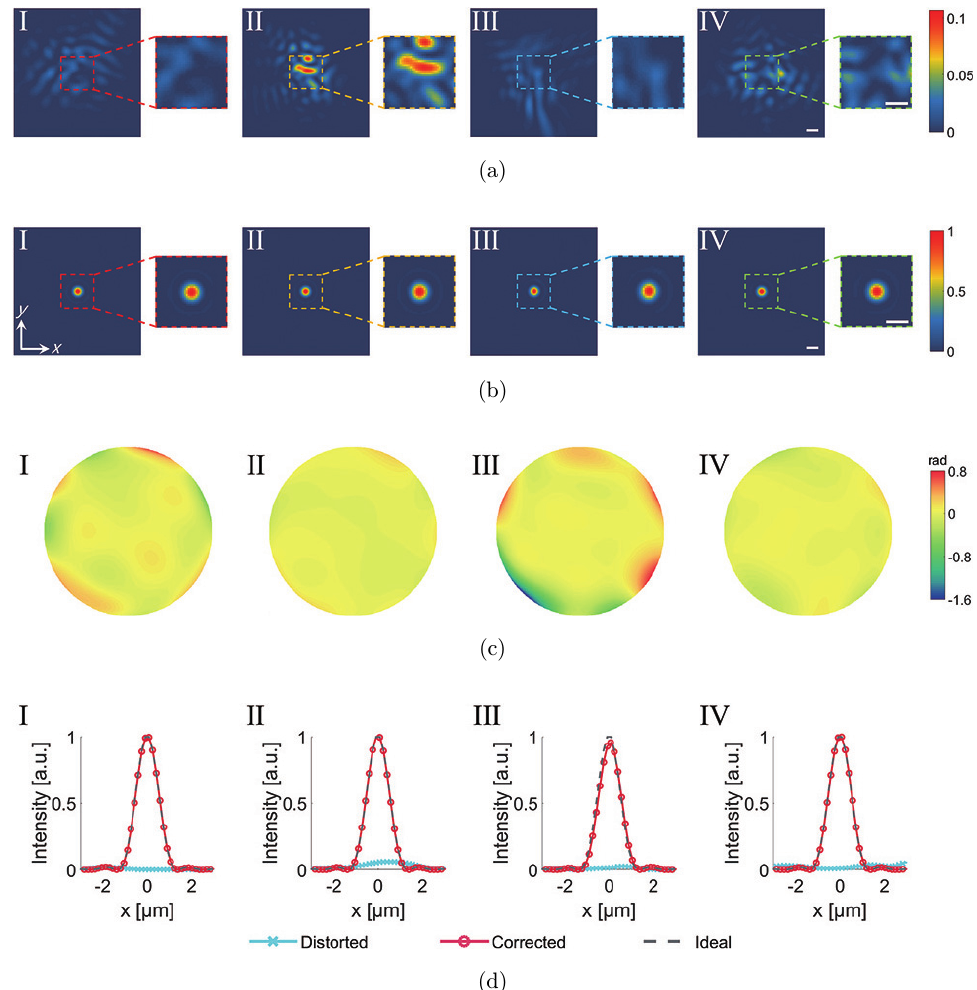
Fig. 6. The focusing results of optical distortions compensation from repetition tests. (a) The PSFs of the distorted wavefront. (b) The PSFs of the corrected wavefront. (c) The corrected wavefront after compensating with predicted Zernike mode coe±cients. (d) Intensity distributions of PSFs in x -direction. The scale bar is 2 (cid:2) m. The scale is the same in (a) and